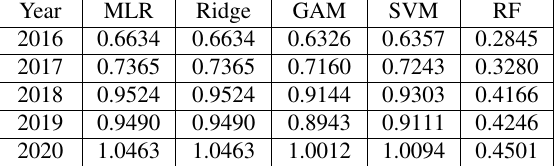
Table 3. Models’ RMSE (Predicted vs